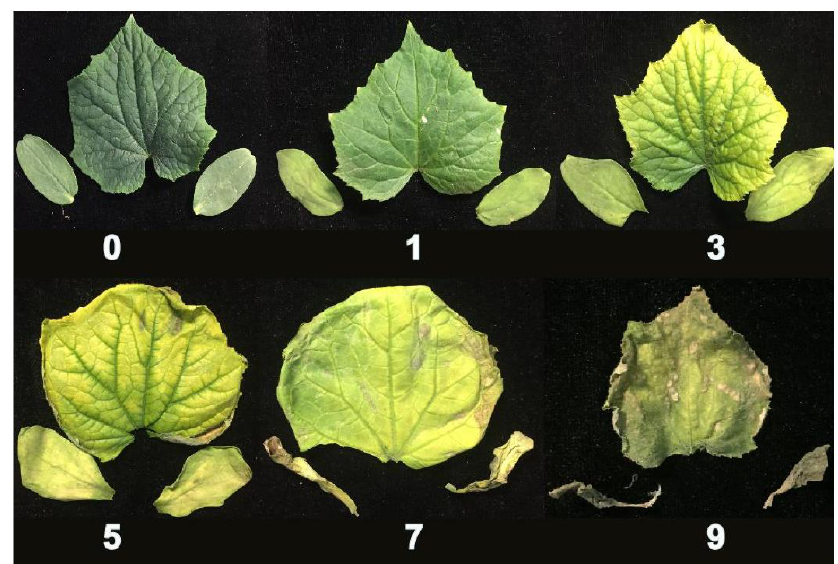
Figure 1. The classification standard to grade salt injury in cucumber seedlings. 0, the cotyledons and the first true leaf show no symptoms of salt injury; 1, the cotyledons are slightly yellowed; 3, the cotyledons and the first true leaf are significantly yellowed; 5, the cotyledons are yellowed and wilted, and the first true leaf is significantly yellowed and wilted; 7, the cotyledons are dehydrated, the large areas of first true leaf are yellowed and wilted; 9, both the cotyledons and the first true leaf are yellowed and dehydrated. Table 1. The salt injury indexes of the parental lines, F 1 plants, and recombinant inbred line (RIL) populations.